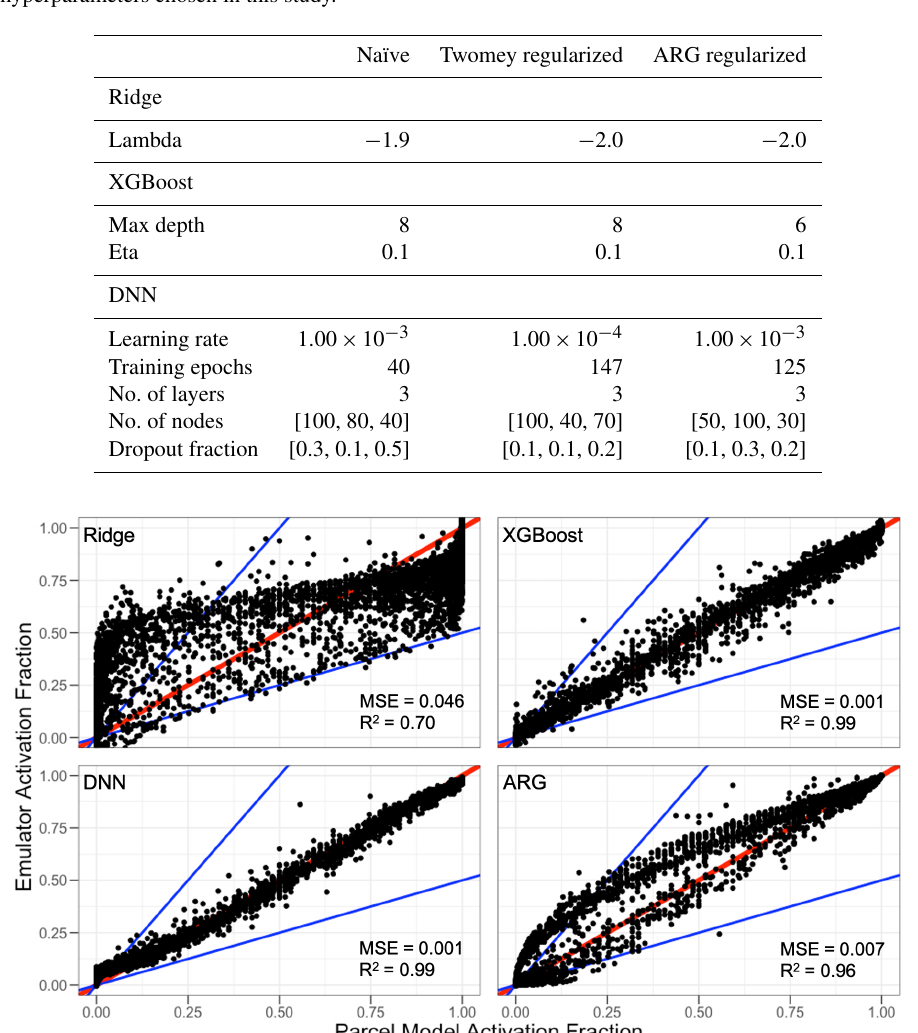
Figure 2. Scatterplot comparisons of the three physically naïve machine learning emulators and the ARG scheme predicted activation fraction with the detailed parcel model. The 1 : 1 line is in red, and the blue lines represent a factor of 2 difference. Performance statistics are given in each